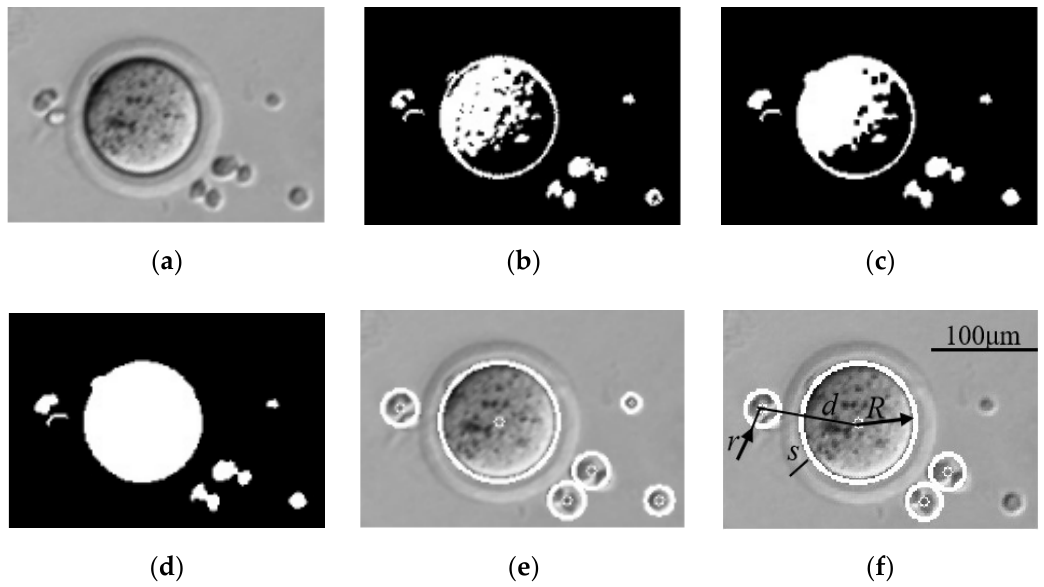
Figure 3. Image sequence of oocyte and cumulus cell recognition. ( a ) Gaussian low-pass filtering image; ( b ) Adaptive thresholding with the Otsu method; ( c ) Morphological close operation creates a smooth oocyte; ( d ) Filling operation fills the holes of oocyte surface; ( e ) Least square fitting to obtain circle contours; ( f ) Oocyte and cumulus cell recognition based on contour area and center distance between oocyte and cumulus cells, where d is center distance between oocyte and cumulus cells, R is radius of oocyte, r is radii of cumulus cells, s is thickness of zona pellucida, s ≈ 8 μm.